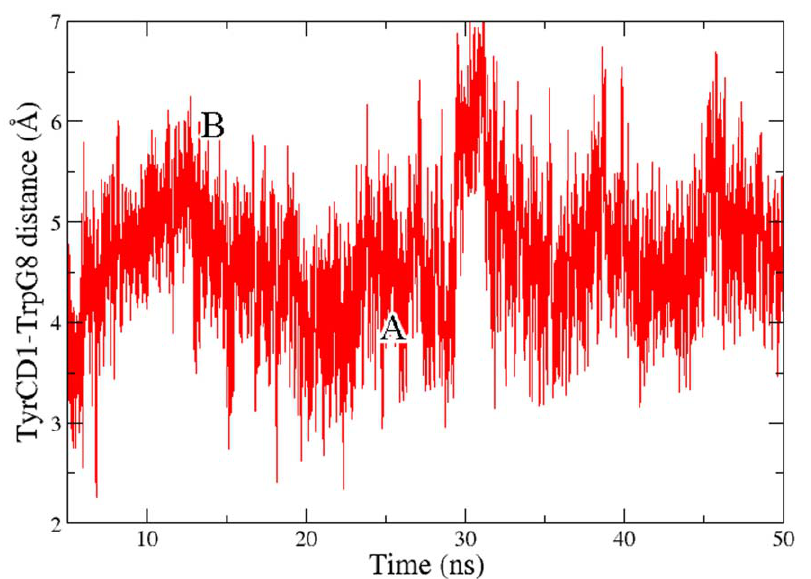
Figure 7. Molecular dynamics simulations. Time evolution of distance between TyrCD1 and TrpG8 side chains along 50 ns MD simulation. Frequency information and swapping configurations of TyrCD1 related with the presence of (trHb:CO) 3 can be appreciated (labeled A and B). ‘‘A’’ ( , 4 A˚) corresponds to the conformation depicted in Fig. 6A while ‘‘B’’ ( , 5.75 A˚) corresponds to the conformation showed in Fig. 6B.